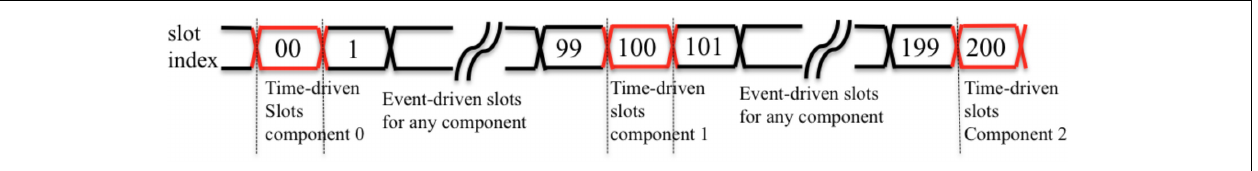
FIGURE 4 | Timing diagram of the advanced time-multiplexing approach.